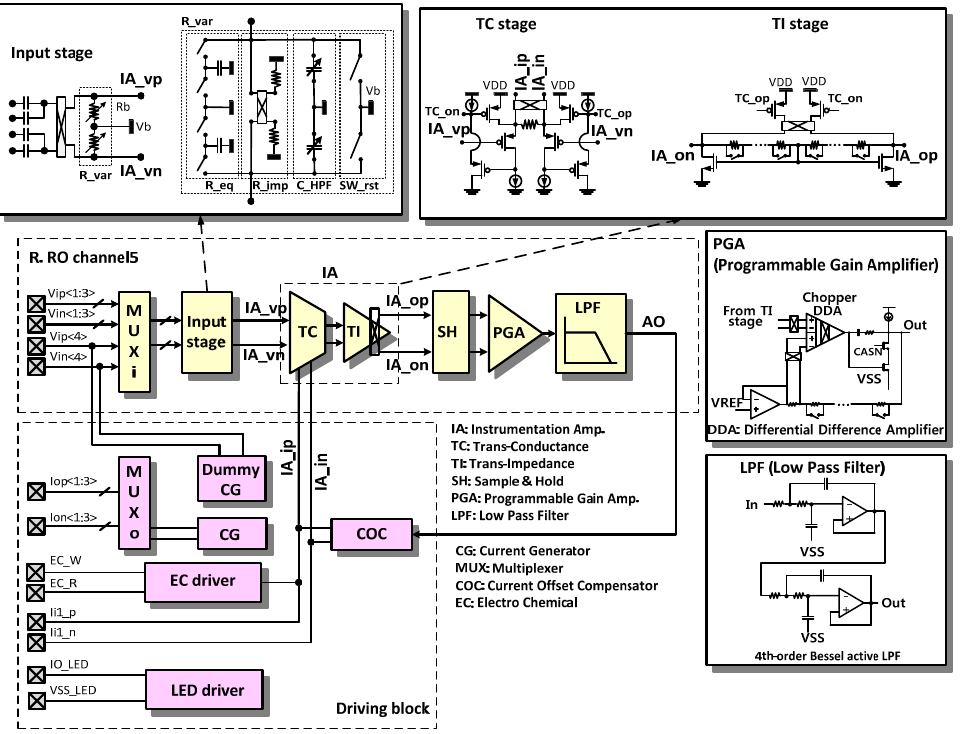
Figure 4. Architecture of the reconfigurable channel.